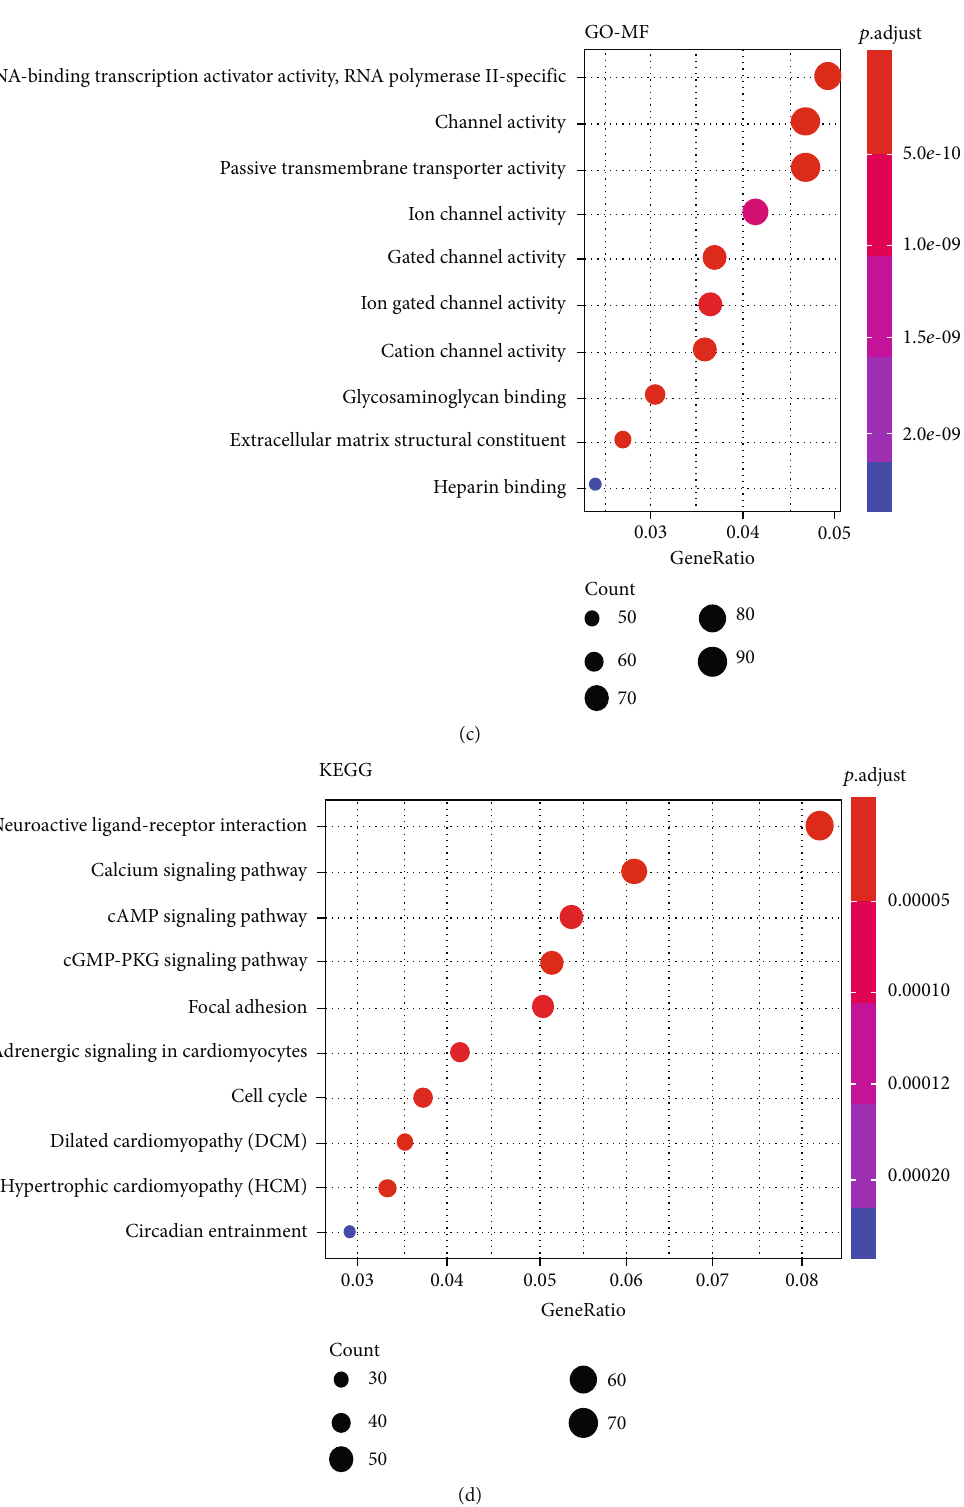
Figure 2: Functional enrichment analysis of the overlapped DGEs by GO and KEGG pathway analysis. (a) Results of the DEGs that were enriched in the biological process by GO analysis. (b) Results of the DEGs that were enriched in the cellular component by GO analysis. (c) Results of the DEGs that were enriched in the molecular function by GO analysis. (d) Results of the DEGs that were enriched in the metabolic pathway by KEGG pathway analysis. GO: Gene Ontology analysis; KEGG: Kyoto Encyclopedia of Genes and Genomes pathways analysis; GO-BP: biological process; GO-CC: cellular component; GO-MF: molecular